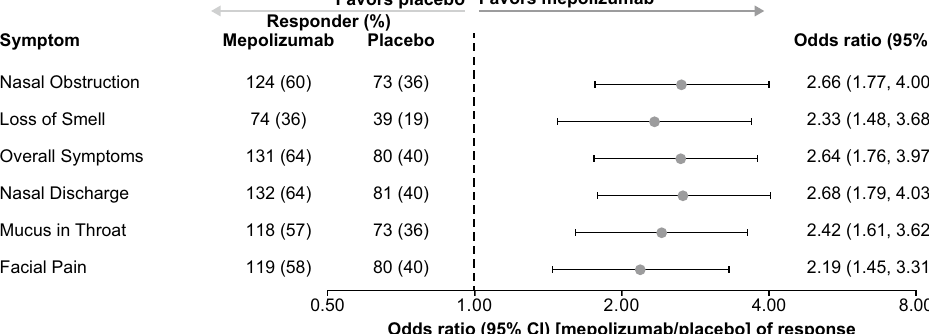
Fig. 4 Probability of meaningful within-patient change † in VAS score (Weeks 49–52). * P < 0.001; † symptoms, nasal discharge, and facial pain VAS scores, and a